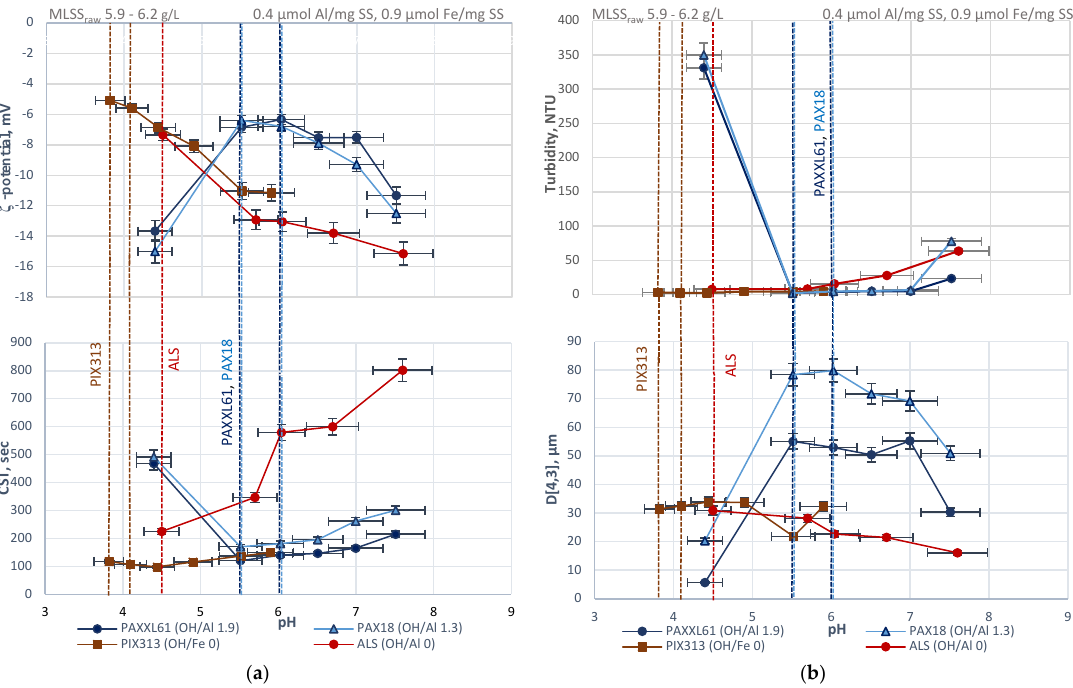
Figure 4. Determination of the optimum pH at fixed coagulant dose during the jar tests according to: ( a ) zeta potential, capillary suction time (CST); ( b ) turbidity, the volume moment mean.